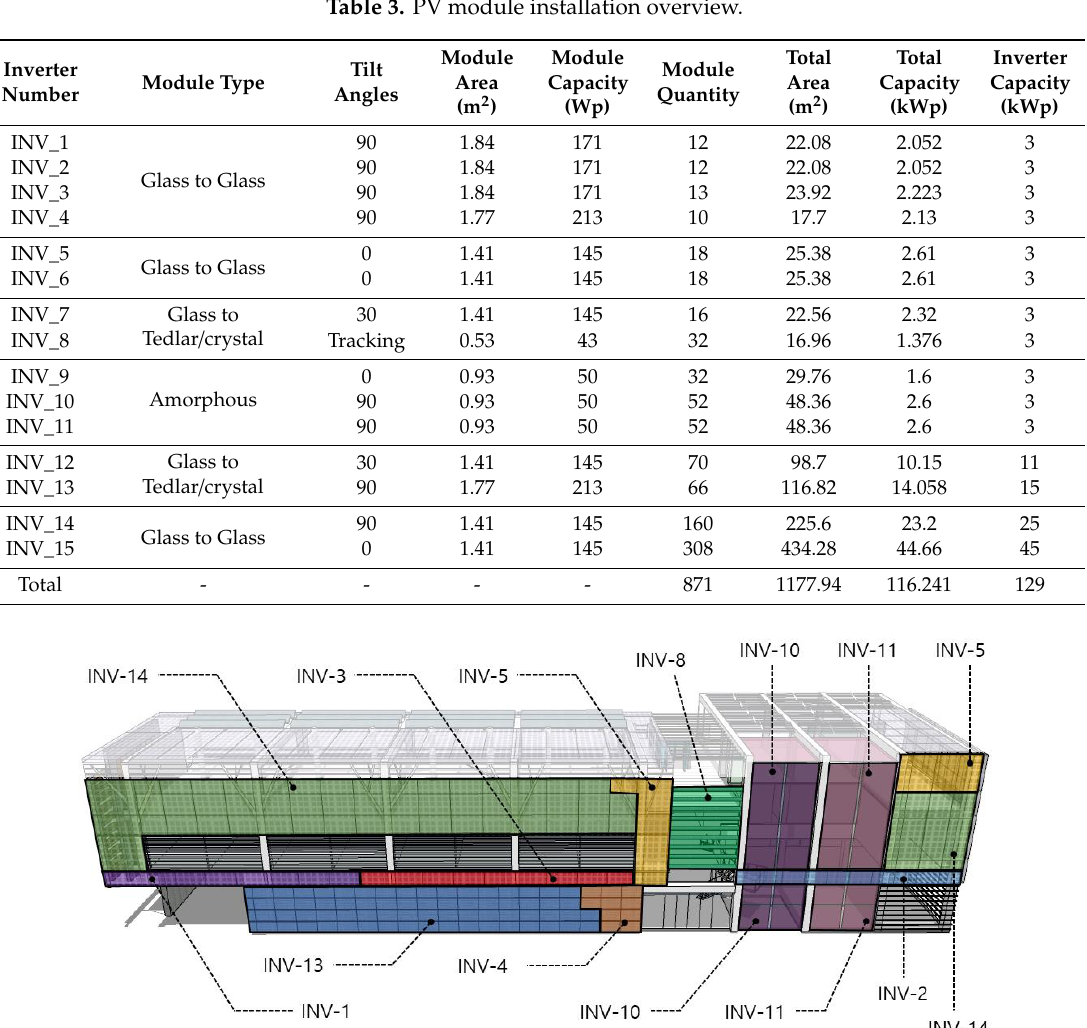
Figure 3. Detailed diagram of the BIPV array installation on the roof of the Carbon Zero Building. 3.2. Monitoring system Figure 4 shows the electric power system and monitoring system of the Carbon Zero Building. To investigate the power generation characteristics of each array, data were collected by connecting a power monitoring module bus to 15 PV inverters. To measure the total generated power, an additional watt-hour meter was installed at the front of the transformer where the power generated from each inverter was collected. Moreover, data required for the detailed analysis of the BIPV systems were secured by installing pyranometers, thermometers, and hygrometers. In addition, a watt-hour meter was installed to measure the electric power used in the building and the power transmitted to and received from the power system. These sensors were connected to the integrated management system to collect data in real time.